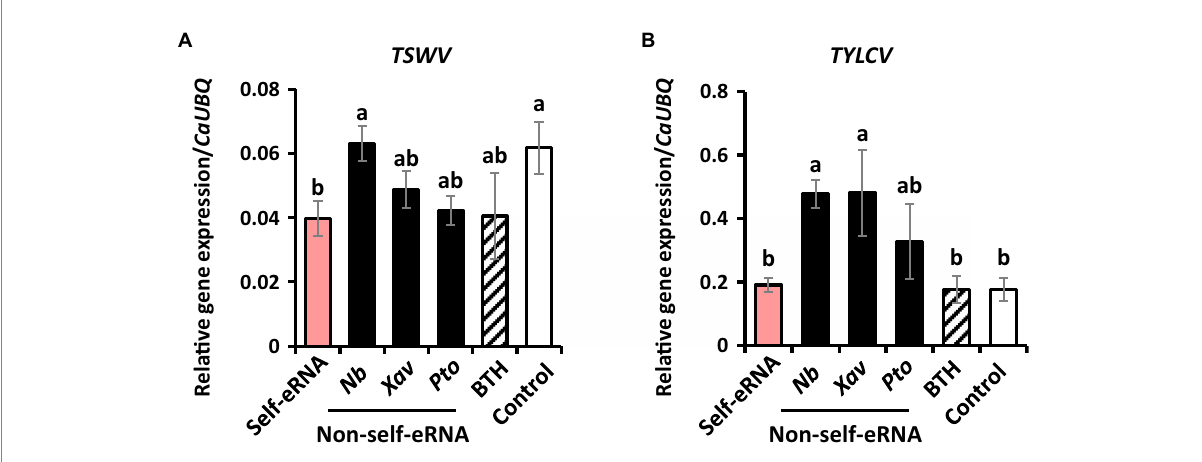
FIGURE 2 Self-eRNA treatment induces plant immunity against the naturally occurring Tomato spotted wilt virus (TSWV) and Tomato yellow leaf curl virus (TYLCV) . Induction of immunity against TSWV (A) and TYLCV (B) in pepper plants by pre-infiltration with self-eRNA (derived from pepper) and non-self-eRNA derived from N. benthamiana (Nb) , X. axonopodis pv. vesicatoria (Xav) , and P. syringae pv. tomato (Pto) . BTH treatment used as a positive control. The expression of immunity-related genes was evaluated by qRT-PCR at 90 days post-infiltration. The housekeeping gene CaUBQ was used as an internal reference. Data represent mean ± SEM. Different letters indicate statistically significant differences between control and other treatments ( p = 0.05; LSD test).